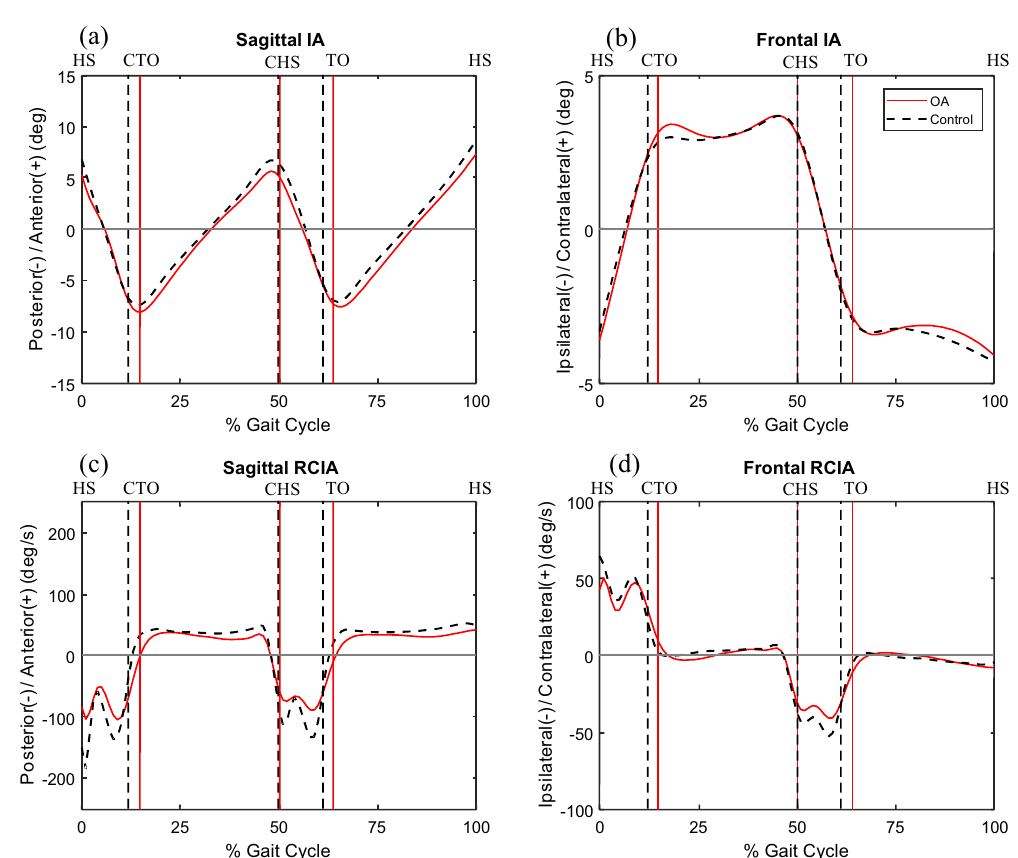
Figure 2. Mean curves of the COM–COP inclination angles (IA) and their rates of change (RCIA) in the sagittal ( a , c ) and frontal ( b , d ) planes for the knee osteoarthritis group and the control group during level walking. Gait events, namely heel-strike (HS), contralateral toe-off (CTO), contralateral heel-strike (CHS) and toe-off (TO), are indicated by vertical lines. Positive sagittal and frontal IA indicate COM positions that are anterior and contralateral to the COP, respectively. Positive sagittal and frontal RCIA indicate rates of anterior changes and contralateral changes in the corresponding IA,